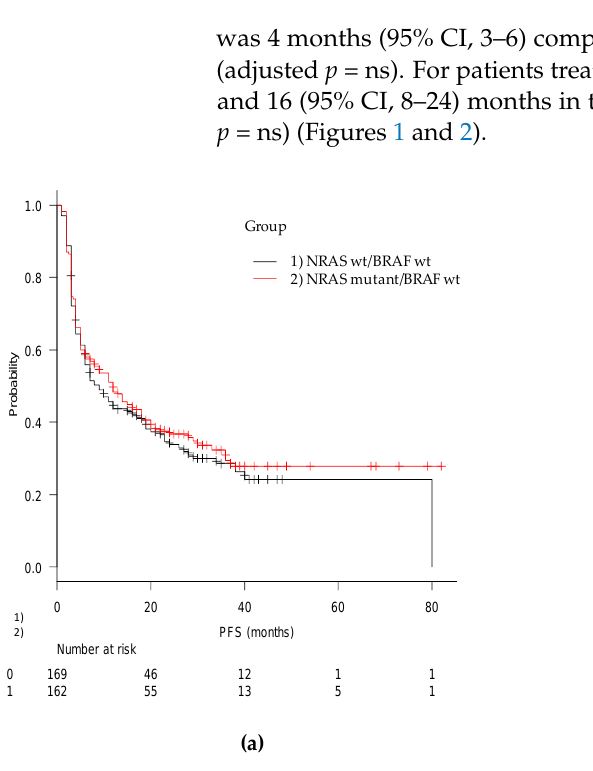
Figure 1. Kaplan-Meier curves of progression free survival from first-line immune-based therapy in ( a ) the mut/wt and wt/wt cohorts and in ( b ) the two groups according to checkpoint inhibitor utilized (anti-PD-1 and anti-CTLA4). Table 7. Univariate and Multivariable analysis of progression-free survival.